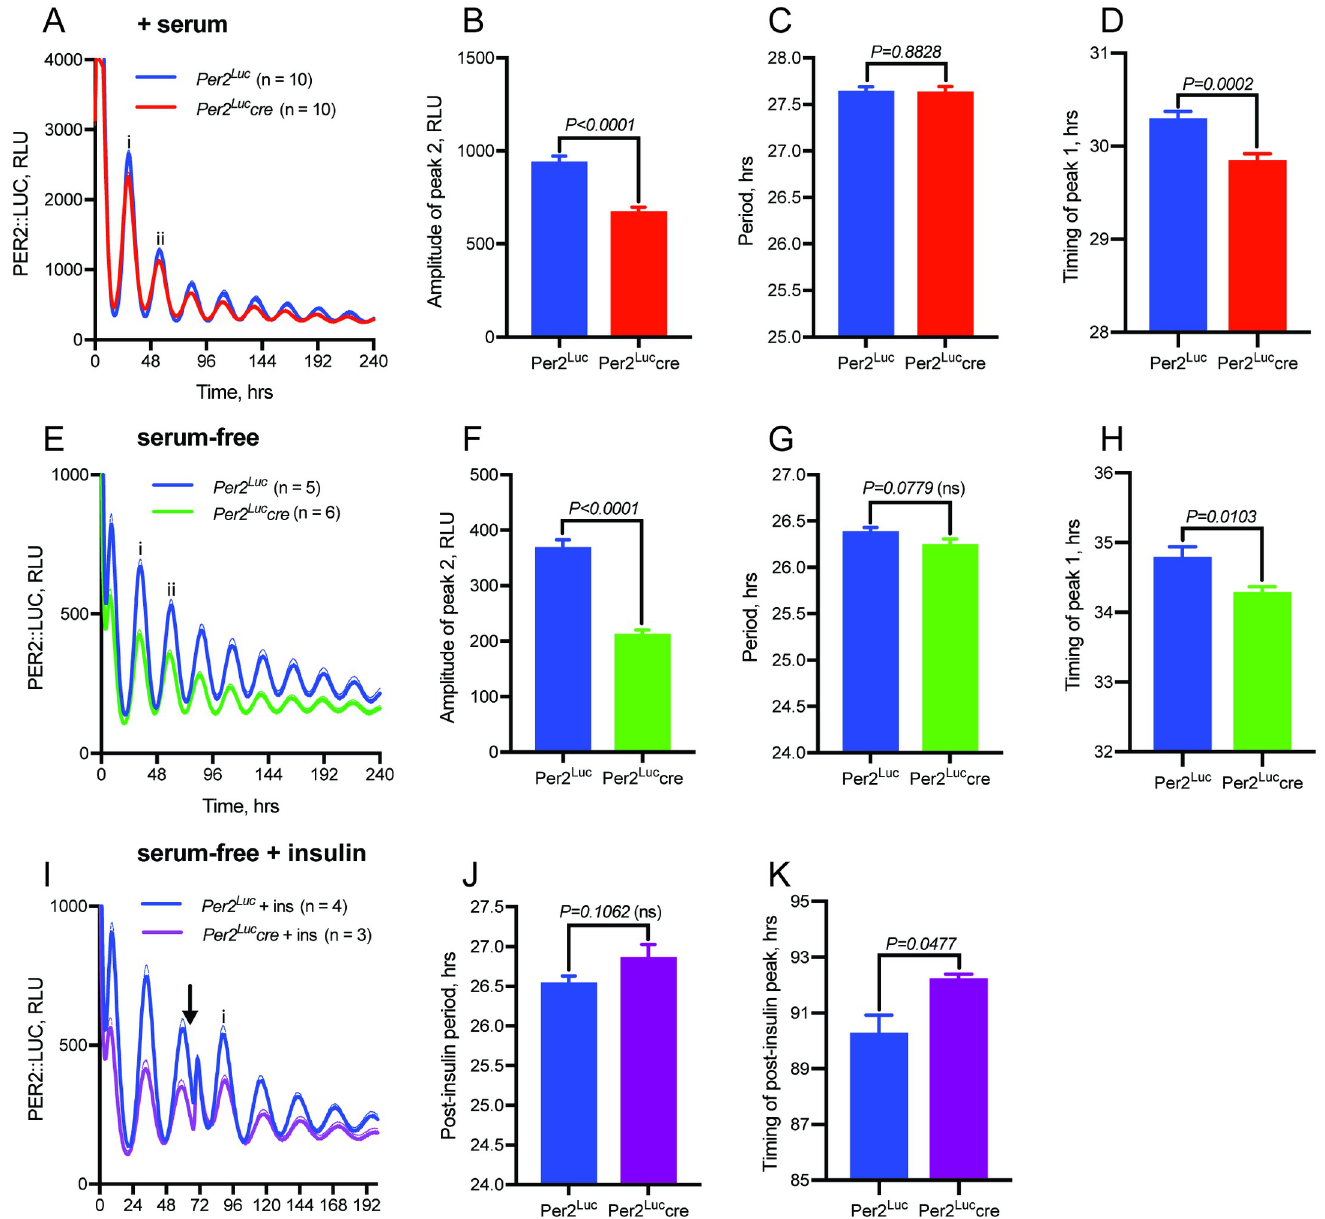
Fig 9. Presence of 3’-UTR neomycin resistance cassette modulates amplitude and phase-resetting in Per2 Luc cells. A. Bioluminescence recordings from mPer2 Luc and mPer2 Luc cre lung fibroblasts in serum-containing media. B. Removal of the neomycin-resistance cassette from the Per2 3’-UTR using transiently- expressed Cre recombinase ( mPer2 Luc cre ) reduces rhythm amplitude, as measured at peak ii, but (C) does not significantly influence period. D. Removal of the Neo cassette results in altered phase resetting in response to a media change at time 0, as measured by timing of the first circadian peak ‘i’. E . Representative bioluminescence recordings from mPer2 Luc and mPer2 Luc cre fibroblasts in serum-free media shows comparable results to cells in serum-containing media, with (F) amplitude reduction at peak ii, (G) no change in period, and (H) an approximately 30 minute advance in timing of the first circadian peak in cells lacking the Neo cassette. I. Removal of the neomycin cassette still allows for insulin-induced PER2 expression, with (J) no significant difference in the subsequent period of the oscillation in serum-free media. K . Removal of the Neo cassette alters the phase of resetting following insulin, with an approximately 2 hour delay in the timing of the first circadian PER2::LUC peak following insulin. Arrow indicates addition of insulin.